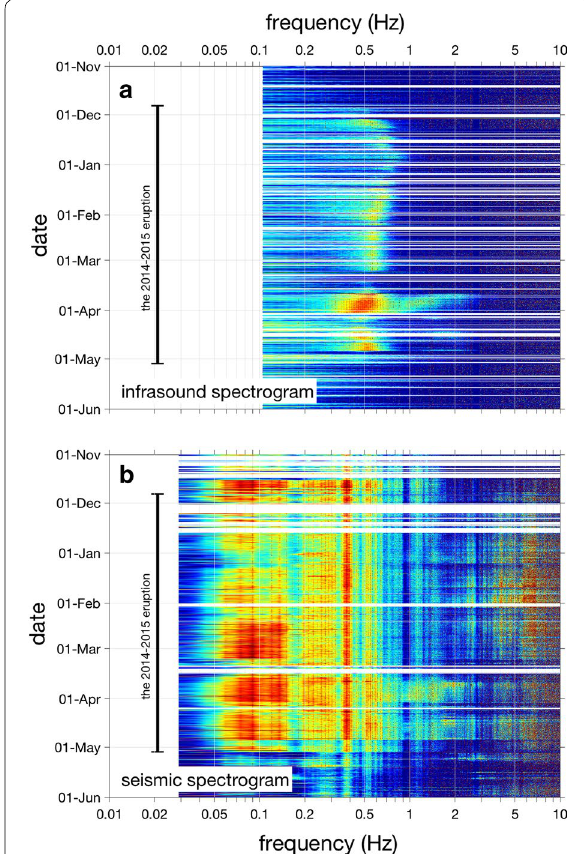
Fig. 6 Spectrograms of infrasound and seismic waves during the 2014–2015 eruption. a Seven-month stacked spectrogram of the infrasound record using reduced data of all the stations to ACM. Data obtained under windy conditions ( ≥ 7.74m/s at JMA; Fig. 1) are eliminated. Black bar on the left-hand side indicates the period of the 2014–2015 eruption. b Spectrogram of the broadband seismic record of the UMA station. Non-functional stations create data